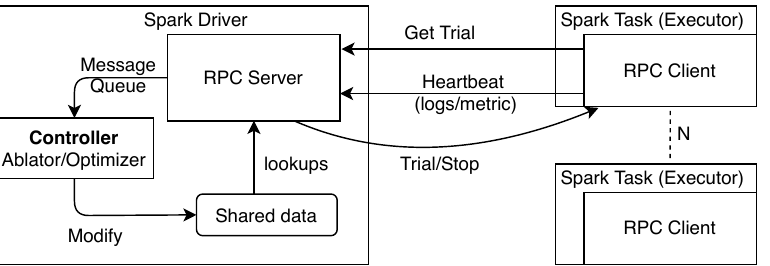
Figure 10. The M AGGY framework’s runtime behaviour and data flow for the RPC protocol